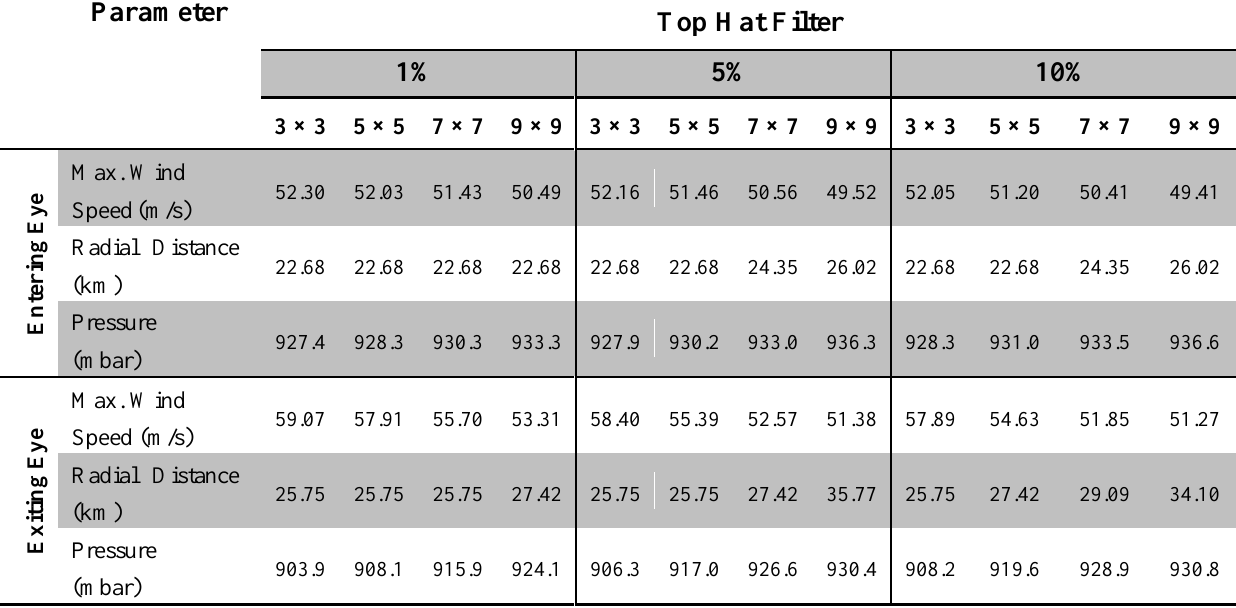
Table 2. Pressure depression for top-hat filters of varying spatial resolution and sidelobe